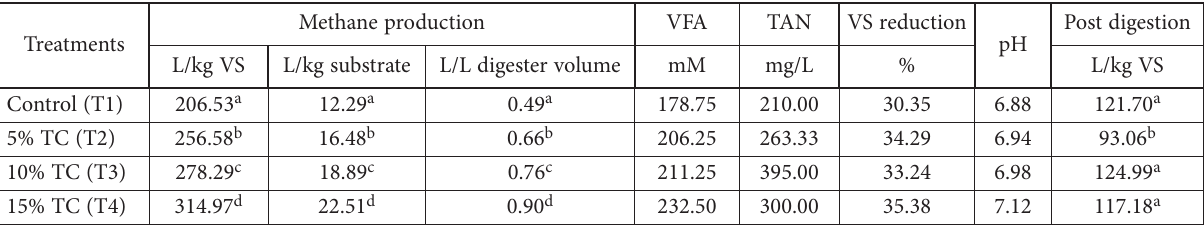
Table 2. Methane yield, total VFA, TAN concentration, VS reduction and pH value of digested slurry from reactor T1, T2, T3, and T4